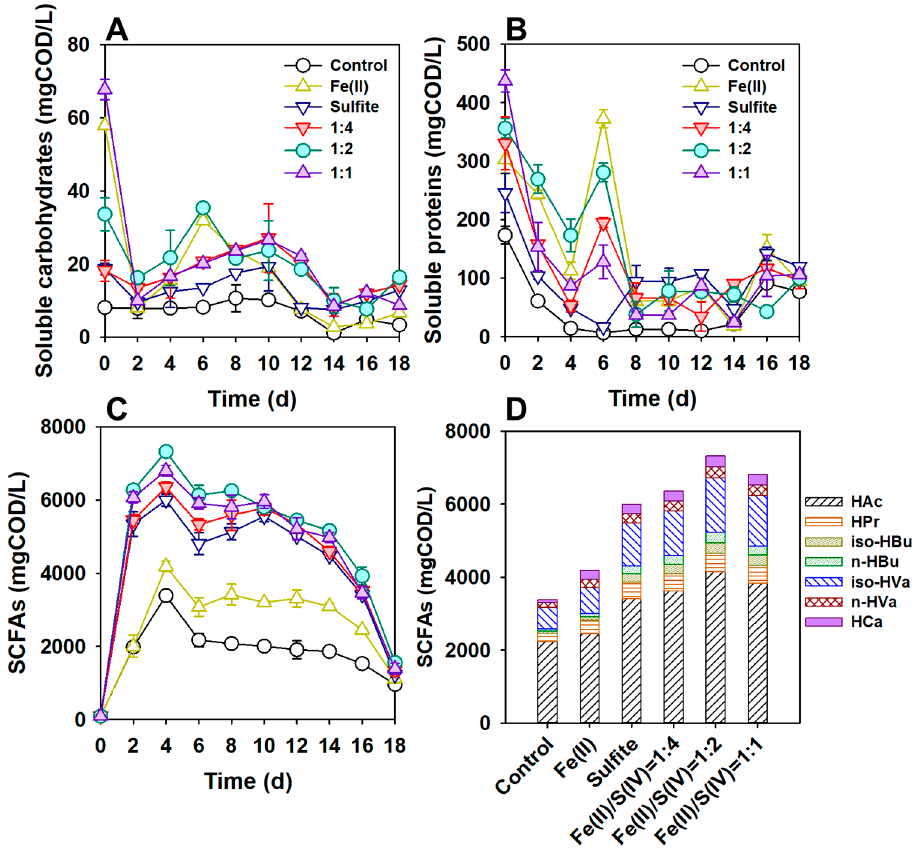
Figure 2. Time-courses of soluble organics during WAS fermentation under different pretreatments: soluble carbohydrates ( A ) and proteins ( B ). Time-courses of SCFAs concentrations ( C ) and the product spectrum on day 4 ( D ).